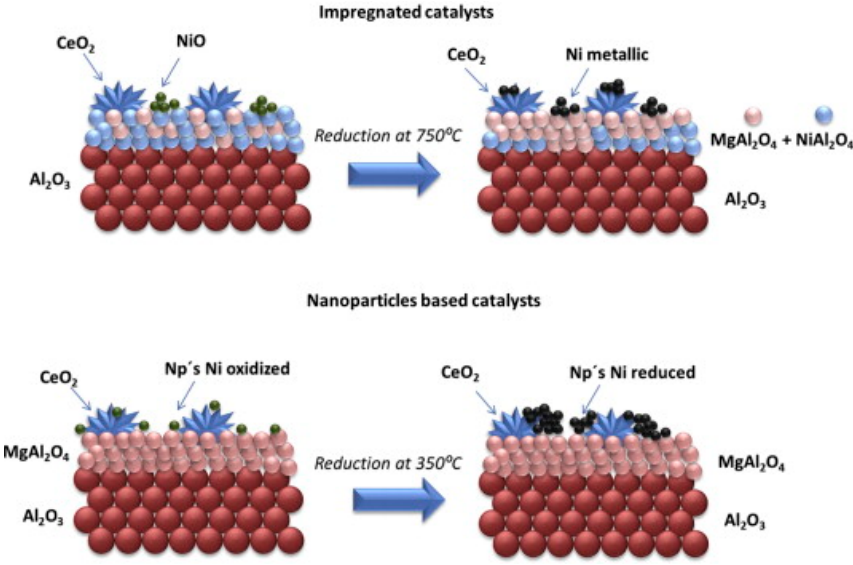
Figure 6 . Model of the catalyst surface and phase distribution before and after reduction for the monometallic catalysts prepared through the impregnation method ( above ) and polyol method ( below ). (Np’s: Nanoparticles). Reprinted with permission from Ref. [41]. Copyright 2022 Elsevier.